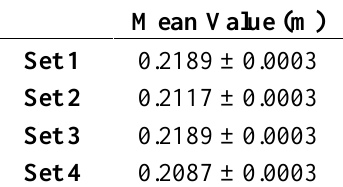
Table 4. Mean displacement values of the sensory system due to material